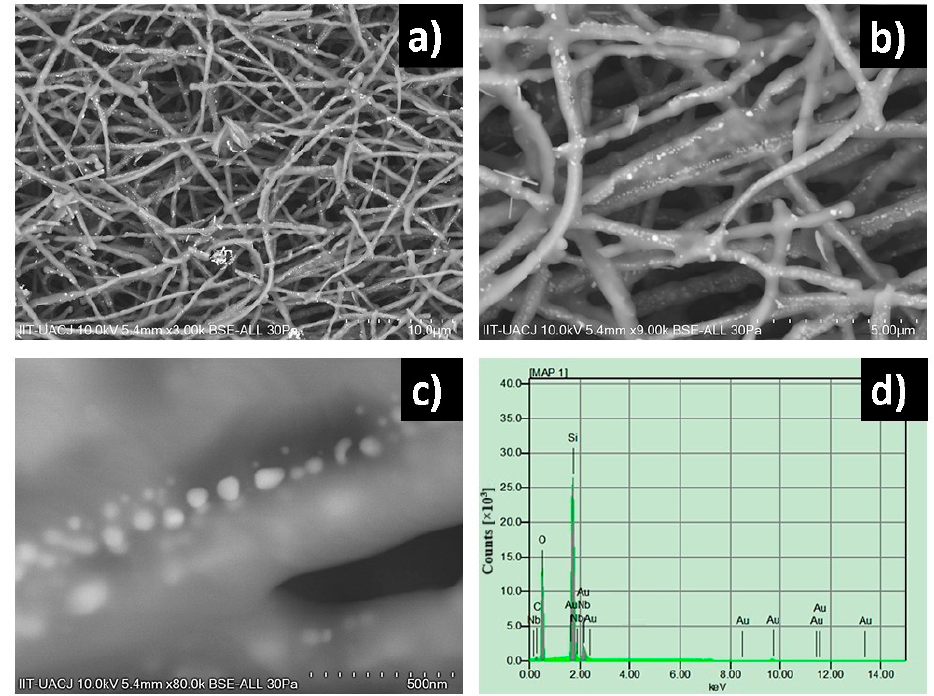
Figure 6. The SEM micrographs of the LiNbO 3 /SiO 2 coaxial fibers at 1000 °C: ( a ) 3000×; ( b ) 9000×; ( c ) 80,000× and ( d ) EDS.